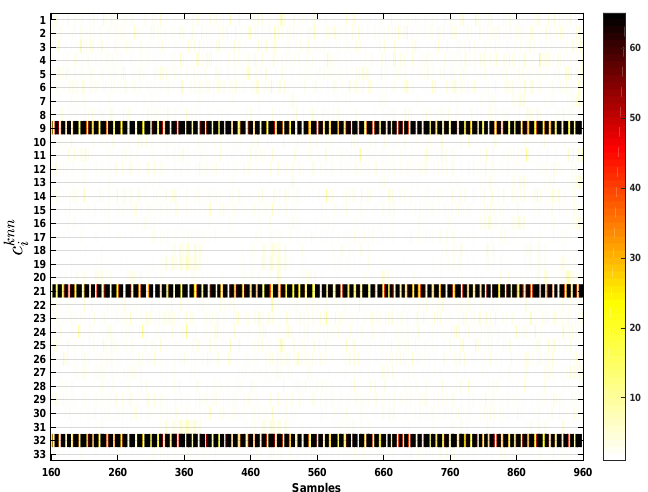
Figure 21. The variable contribution by kNN for fault 14 of TE.